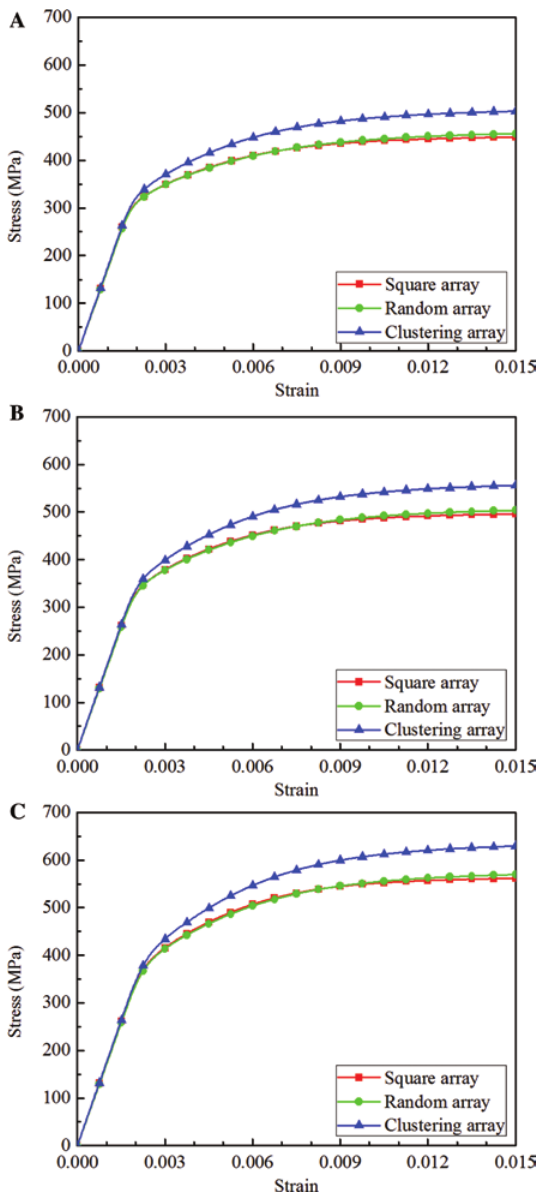
Figure 9: Transverse tensile responses for different fiber arrays at strain rates of (A) 0.01/s, (B) 0.1/s, and (C)